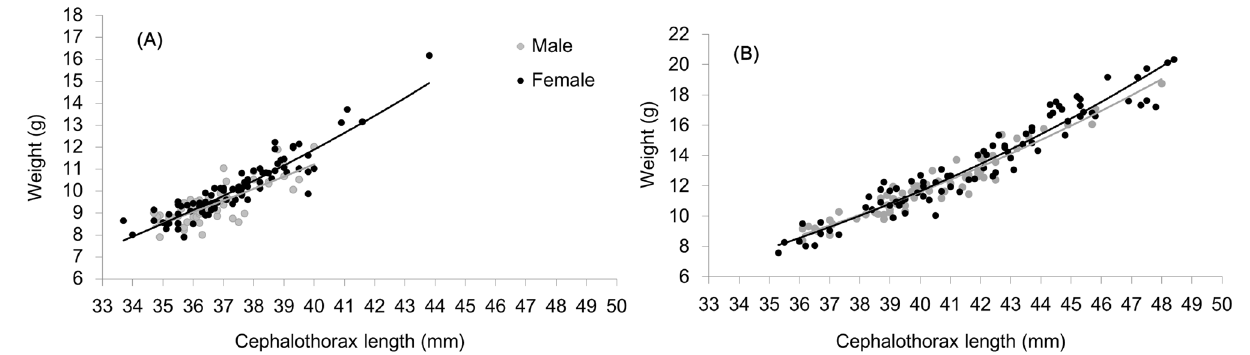
Figure 7. Relationship between cephalothorax length (mm) and individual wet weight (g) by sex of Farfantepenaeus brasiliensis (A) and F. paulensis (B) caught in Rocha lagoon in April